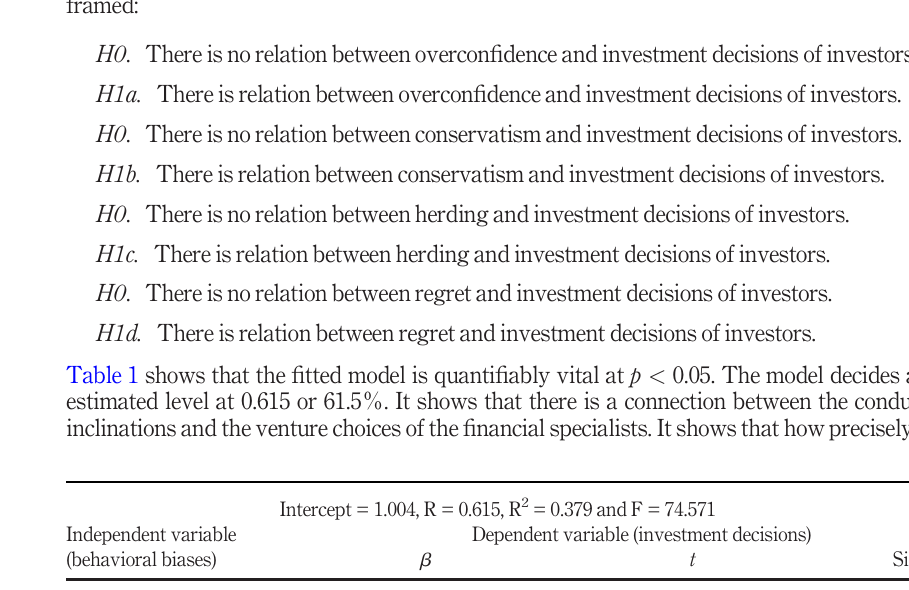
Table 1. Coef fi cients from multiple regression